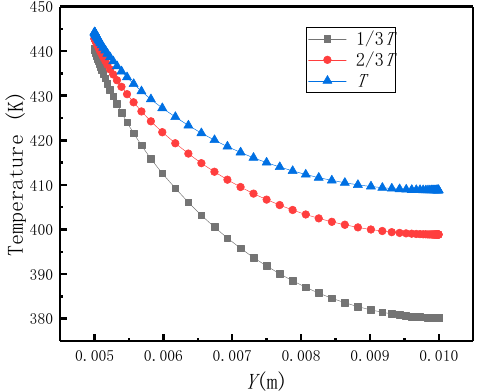
Figure 10. Temperature distribution along the outlet Y direction of cold fluid at different time.